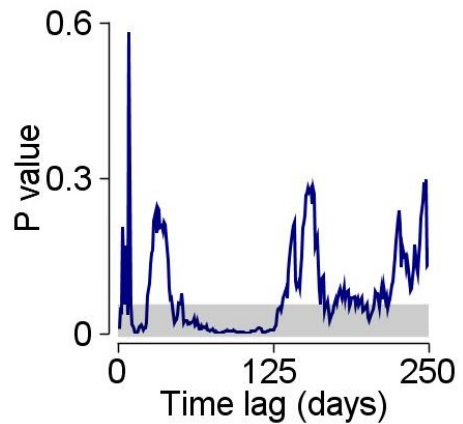
Figure 3. Granger causality test applied to determine for which time lag the data on COVID-19 infection rates is most predictive of suicide-related ER admissions. The gray area indicates the zone where the predictability was statistically significant.